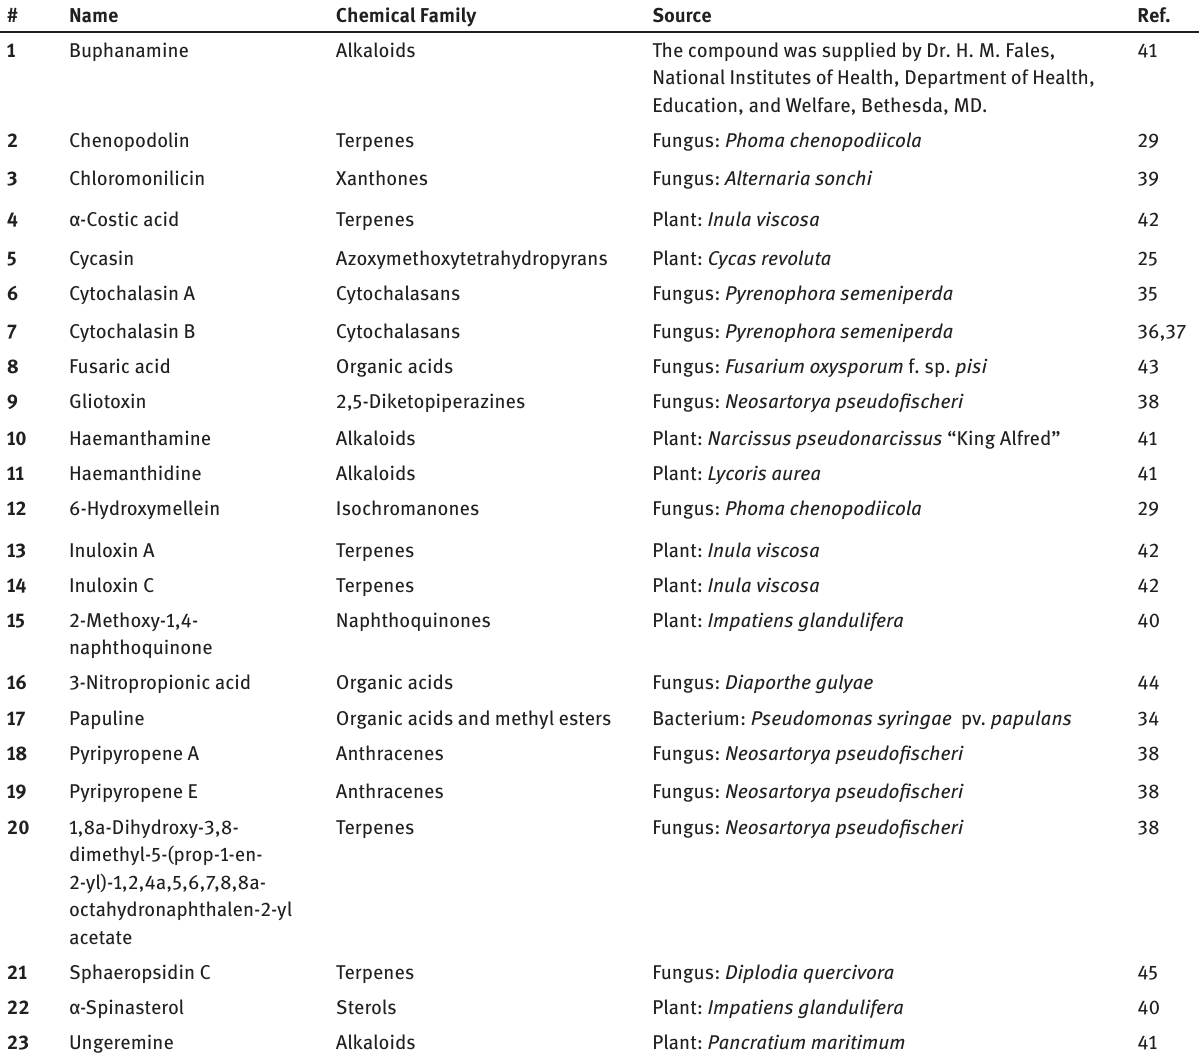
Table 1: Bacterial, fungal and plant metabolites assayed against Ae.